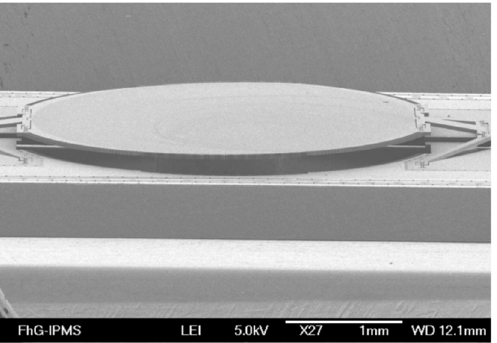
Figure 14. SEM and suspension layout of type B translational MEMS micromirror, using pantograph-type suspensions. (Reprinted with permission from Reference [37] SPIE).